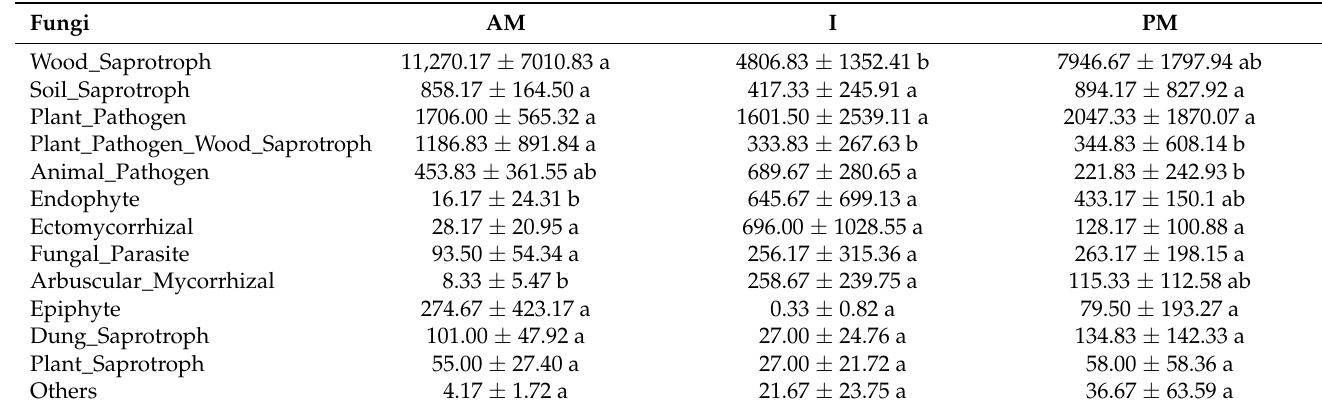
Table A3. Relative abundance of fungi functional groups based on intercropping under the FUN- Guild tool.